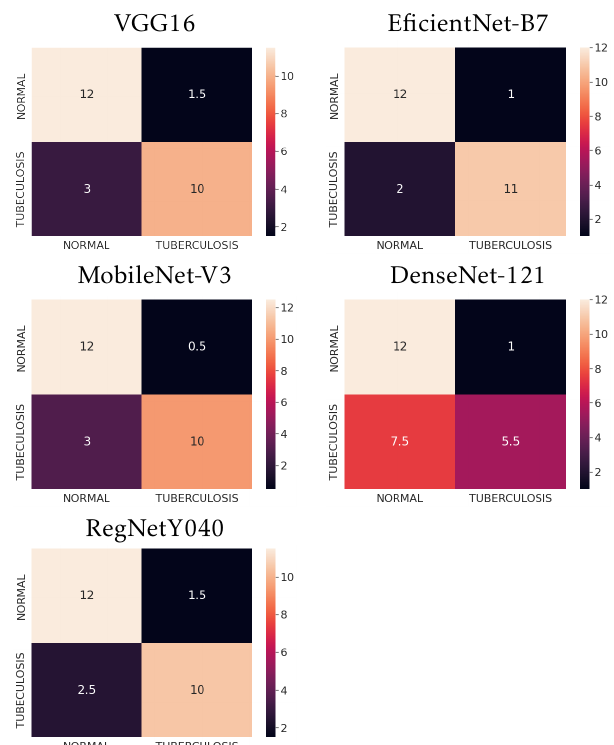
Figure 13. Confusion matrices for models applying to India Chest X-ray Set - MobileNet-V3 reveals the good results with True Positive and False Negative images detected are high - 12 and 10